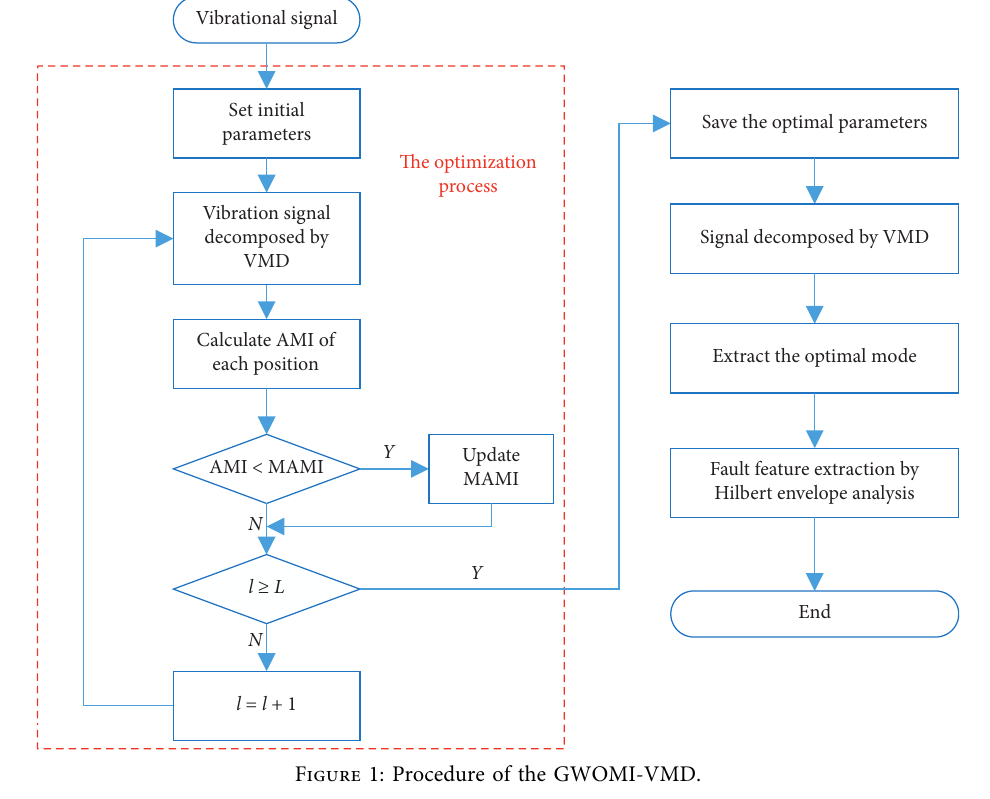
Figure 1: Procedure of the